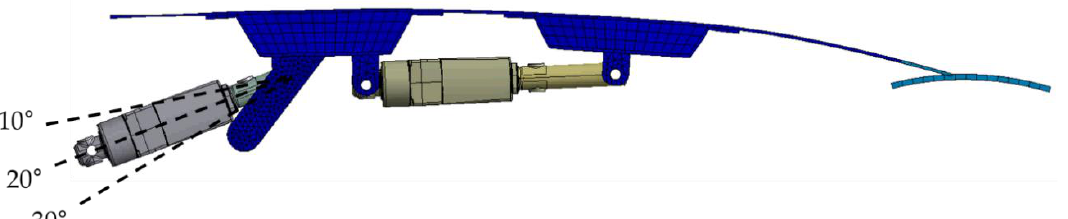
Figure 4. Variation in installation angle of the primary spoiler actuator based on [67].